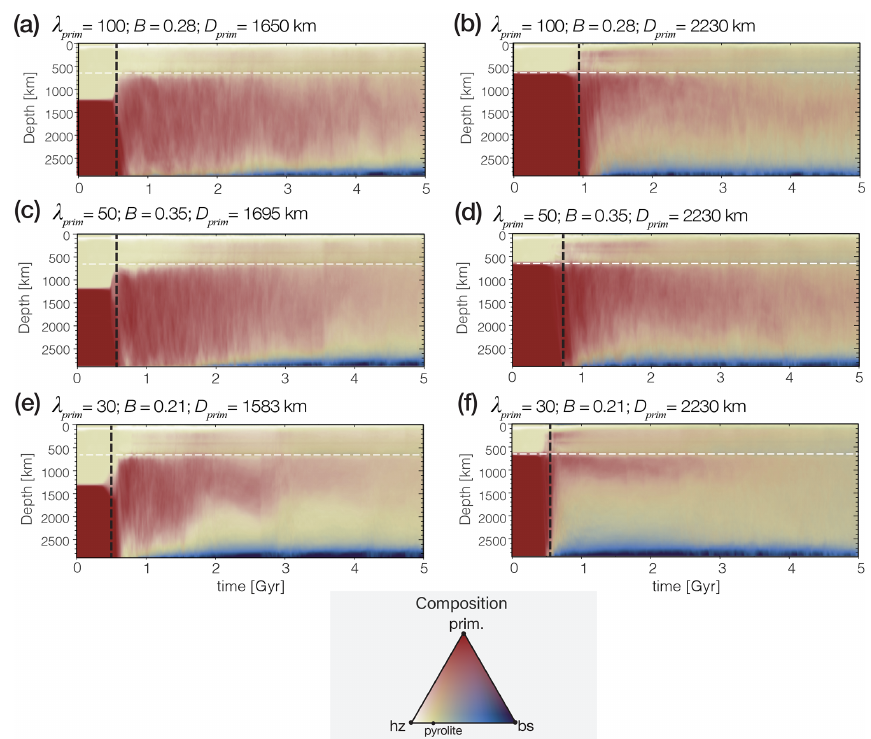
Figure 5. Temporal evolution of the radially averaged compositional profiles of selected models. Models with variable D prim (main model suite) are on the left, and their corresponding model with fixed D prim ( = 2230km, test model suite) is on the right for given B and λ prim : (a–b) B = 0 . 28, λ prim = 100; (c–d) B = 0 . 35, λ prim = 50; (d–e) B = 0 . 21, λ prim = 30. The dotted black line indicates the onset of the compositional overturn. In the test model suite 0 (but not in the main suite), significant amounts of primordial material immediately reach the upper mantle after the